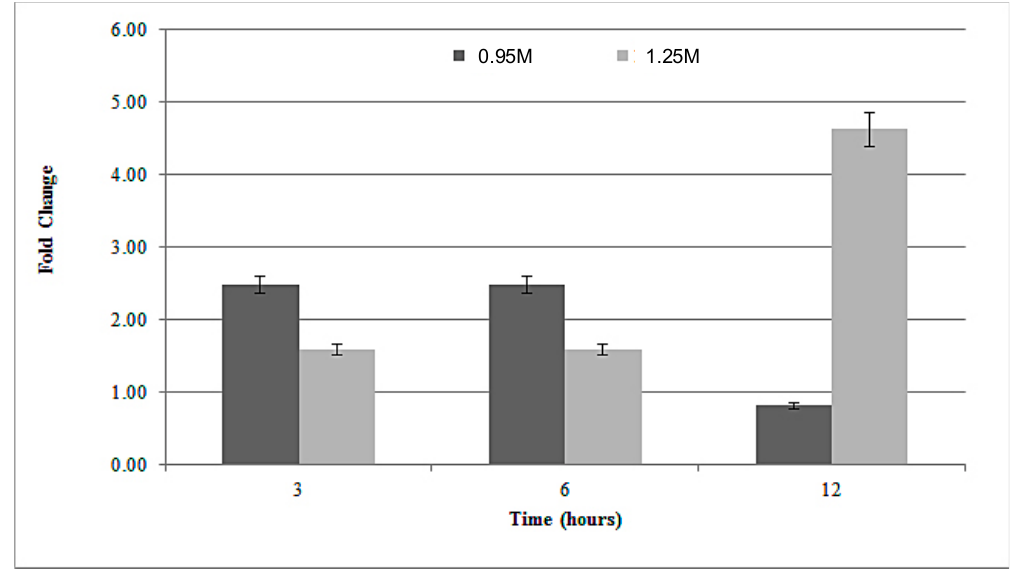
Figure 5. RAD52 gene expression in G. sulphuraria ACUF 074 cells cultured under 0.95 M (dark grey bars) and 1.25 M (light grey bars) NaCl. The mRNA levels were normalized with respect to the level of mRNA for the reference genes (EF1 α and H2B). Bars show means ± standard error (SE) from three independent experiments (n = 3).